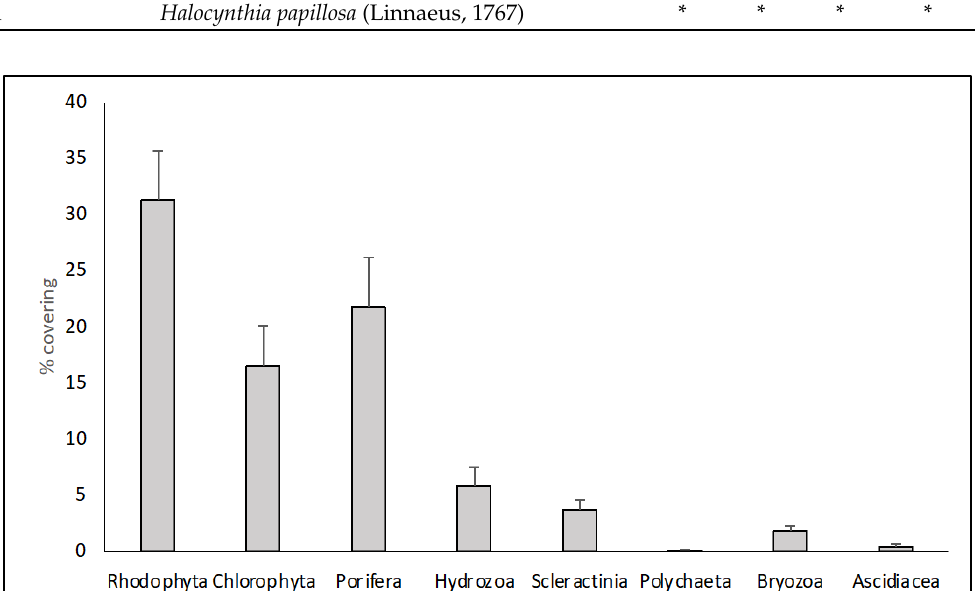
Figure 3. Percentage of covering values (mean ± SD) of the taxa recorded during the study. Table 2. Checklist of the benthic taxa recorded at each site ( * = presence of species). The detailed distribution of macrobenthic taxa at each site, referring to both deep and shallow bioconstruction portions, is shown in Figure 4. The number of species at each site varied between 31 (WE) and 35